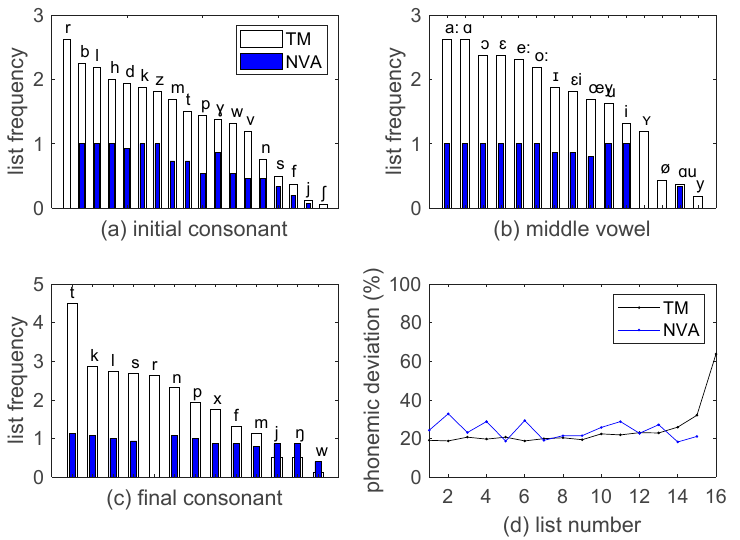
Figure 2. ( a – c ): phoneme count, averaged across lists, for initial, middle, and final position in the CVC